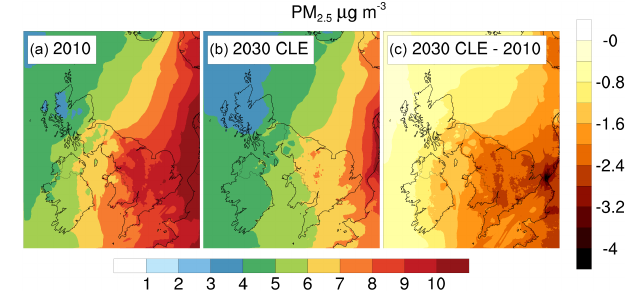
Figure 7. EMEP4UK annual-average surface concentration of PM 2 . 5 (µgm − 3 ) for (a) 2010 emissions, and (b) 2030 CLE emis- sions projection (bottom colour scale), and (c) the difference 2030 CLE – 2010 CLE (right colour scale). The same meteorological year 2010 was